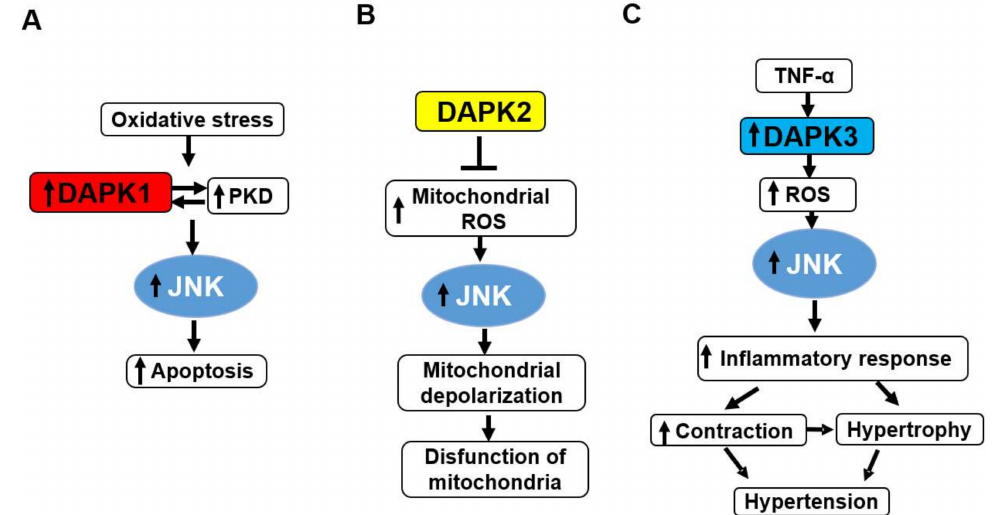
Figure 5. Interaction between DAPK proteins and c-Jun N-terminal kinase (JNK). DAPK1-protein kinase D (PKD) interaction promotes oxidative stress-mediated apoptosis ( A ). DAPK2 regulates the level of mitochondrial ROS through activation of JNK, which might maintain the mitochondrial functions ( B ). DAPK3 might mediate hypertension through propagating vascular contraction and hypertrophy via ROS generation and activation of JNK-dependent inflammatory response ( C ). Arrow indicates promotional effects. T bar indicates the suppressive